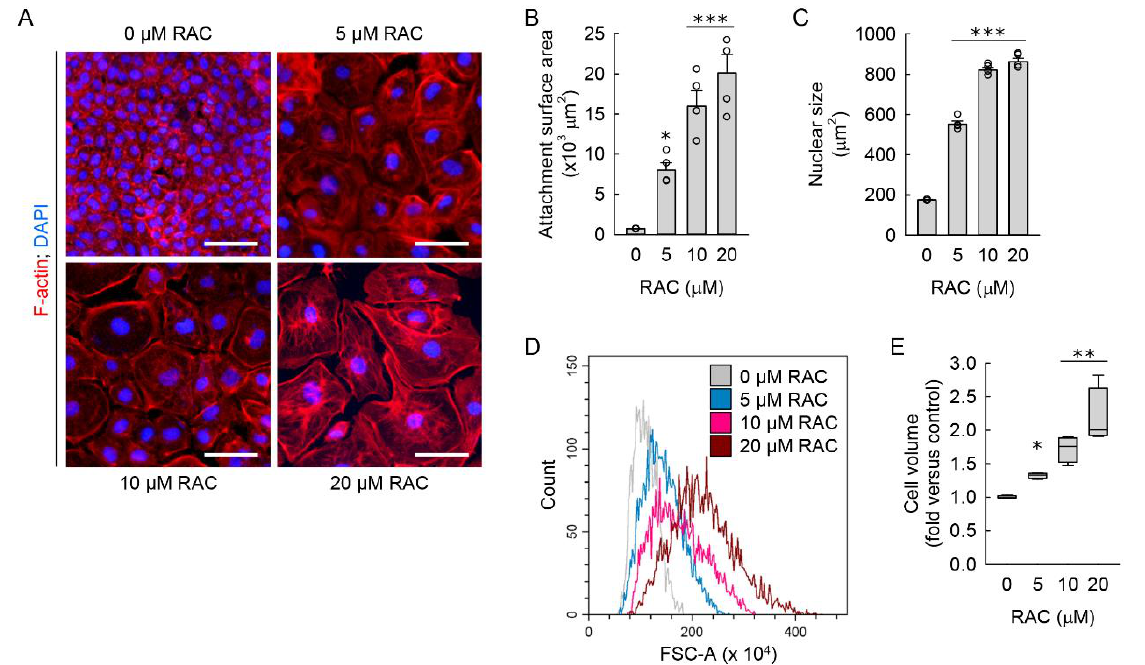
Figure 2. Repeated administration of cisplatin (RAC) induces cellular hypertrophy in kidney fibroblast cells. Normal rat kidney fibroblast NRK-49F cells were treated with 0, 5, 10, or 20 μM cisplatin in normal culture media for 6 h, and the media were replaced with normal culture media, followed by incubation for 18 h. The experiment was repeated three times, and finally, the cells were harvested at 72 h after the first treatment. ( A ) Representative images of F-actin-stained cells at ×400 magnification using the Nikon Eclipse Ni upright microscope (Nikon, Tokyo, Japan), DS-Ri2 camera (Nikon), and NIS-Elements imaging software (Nikon). Total cellular DNA was stained with 4 (cid:48) ,6-diamidino-2- phenylindole (DAPI). Scale bar, 50 µ m. ( B , C ) Quantifications of cell attachment surface area from F-actin staining and cell nuclear size from DAPI staining at × 200 magnification using NIS-Elements imaging software, respectively ( n = 4 experiments). Data are presented as mean ± standard error of the mean with individual data points. Statistical significance was determined by one-way analysis of variance followed by Tukey’s post hoc test (( B ) F 3,12 = 29.303, p < 0.001; ( C ) F 3,12 = 541.88, p <